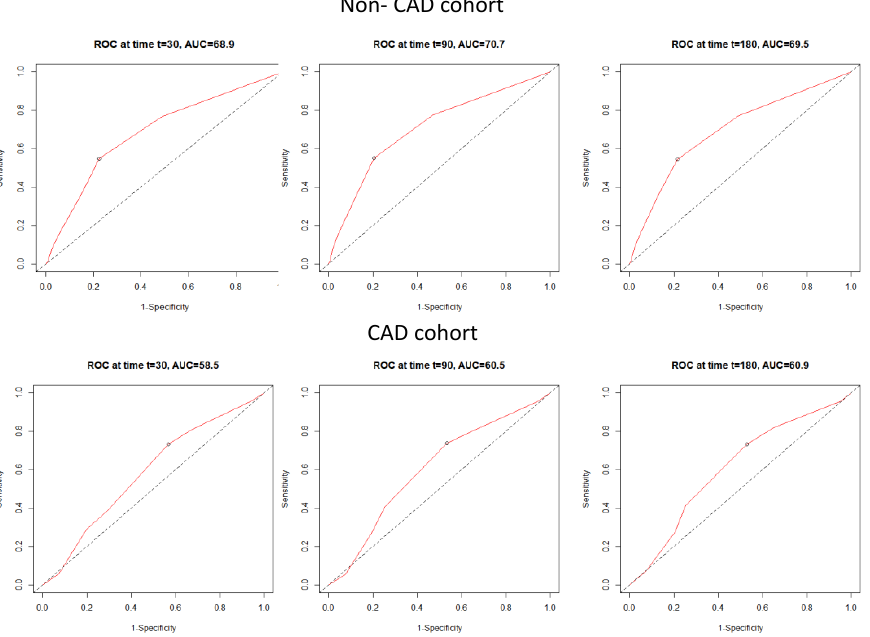
Figure 1. Time-dependent receiver operating characteristic (ROC) curves for all-cause mortality in both study cohorts.